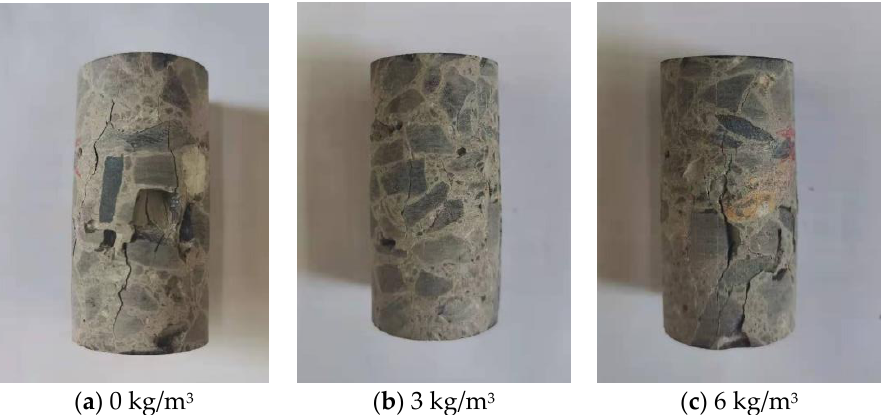
Figure 11. Experimental failure mode of compressive strength of test blocks with different fiber content.